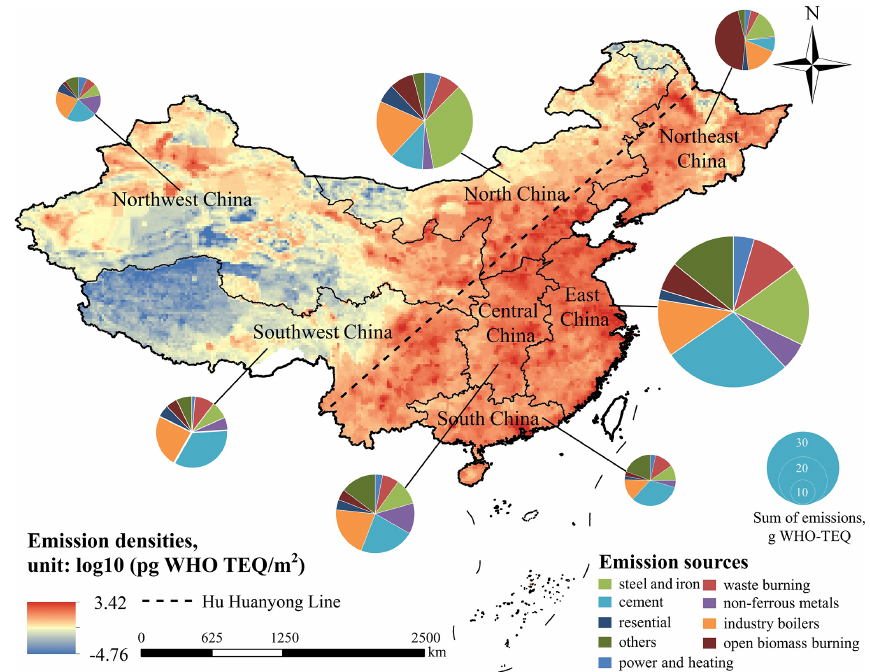
Figure 2. Spatial distribution of emission densities across the Chinese mainland (the resolution is 0 . 1 ◦ × 0 . 1 ◦ ) and the sum of emissions from various emission sources in different regions in 2019.